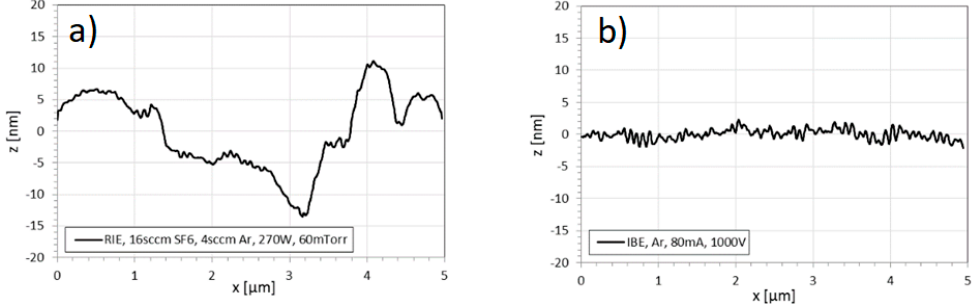
Figure 6. AFM measurements of surface nano roughness ( a ) after RIE, ( b ) after RIE/IBE.